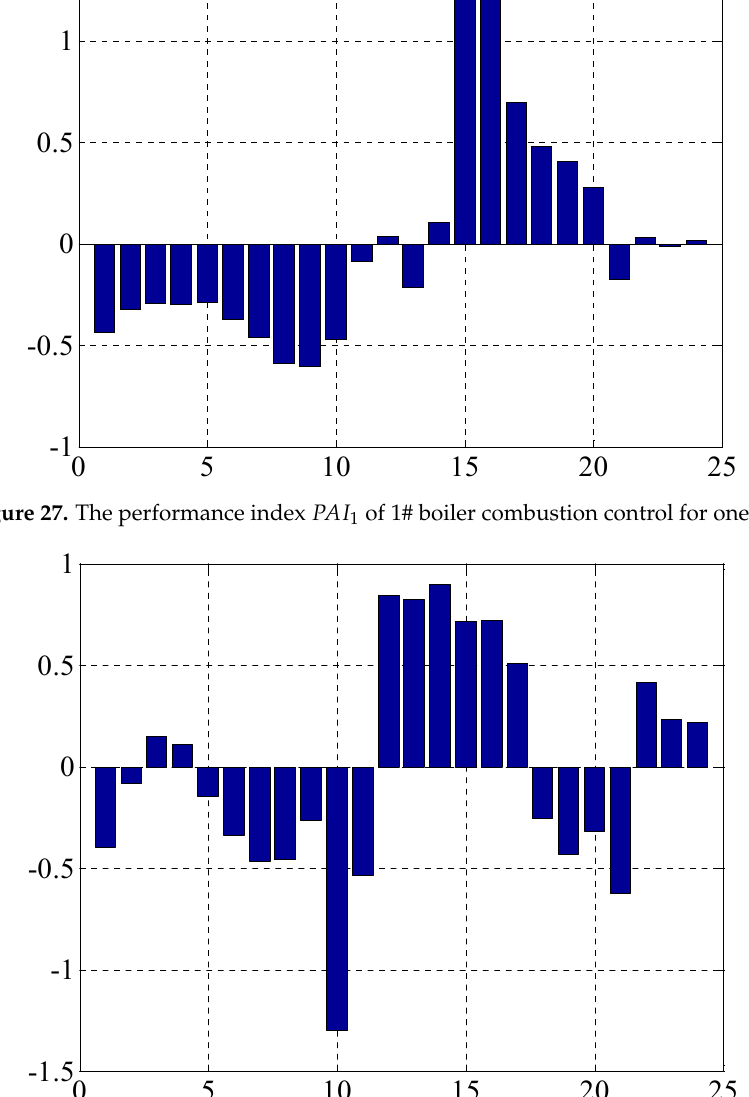
Figure 28. The performance index PAI 2 of 2# boiler combustion control for one day. According to the classification criteria of the performance index in Table 2, the performance indexes of 1# boiler combustion control system are arranged according to the sequence from big to small, and the assessment results are classified, at the same time the percentage of different performance levels is calculated, and the statistical results are shown in Table Table 6. The results and ranking of performance assessment index 1 PAI . (1# Boiler combustion